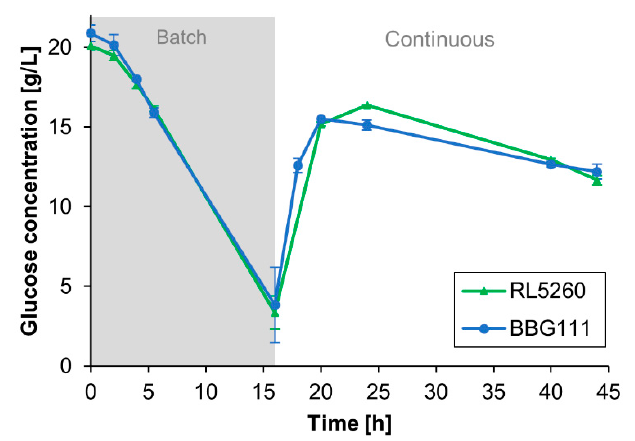
Figure 5. Glucose concentrations present in the bulk medium for the two B. subtilis 168 strains during the cultivation. The standard deviation of the measurements is indicated by error bars.